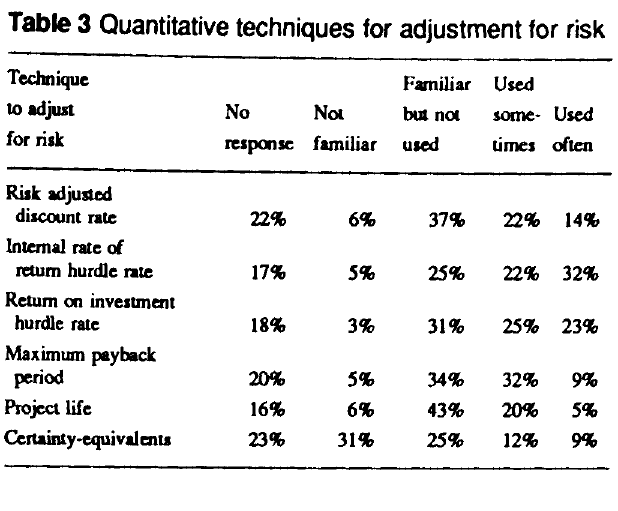
Table 3 Quantitative techniques for adjustment for risk